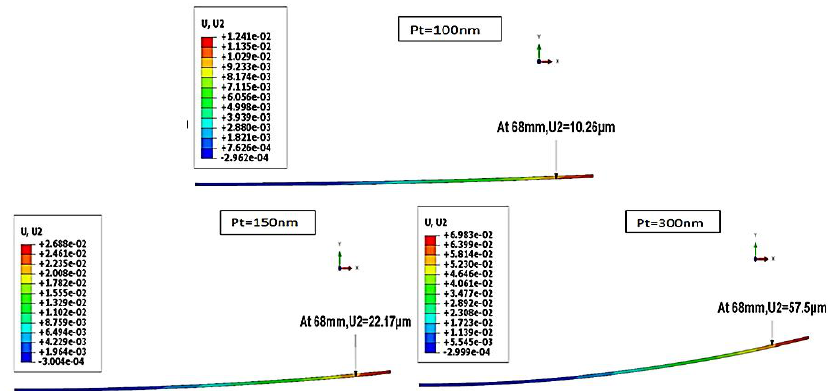
Coatings 2023 , 13 , x FOR PEER REVIEW Figure 5. Warpage of the Si/USG/Pt stack using the full thermal cycle load. Figure 5. Warpage of the Si/USG/Pt stack using the full thermal cycle load.